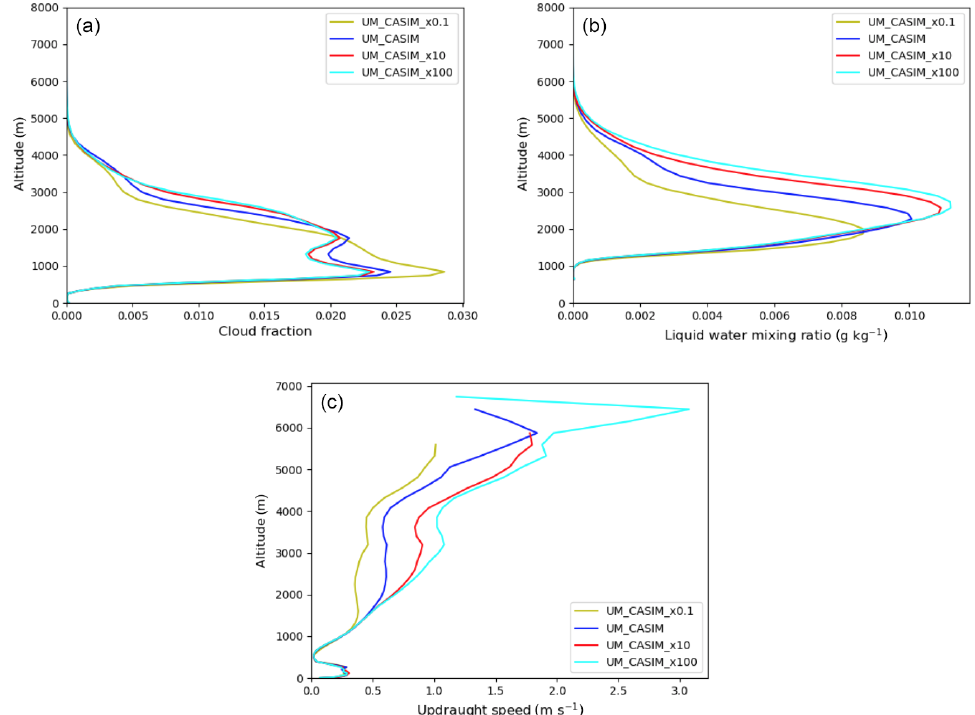
Figure 6. Vertical profiles of domain-averaged liquid water mixing ratio (a) and cloud fraction (b) , calculated for all columns, and updraught speed (c) , calculated for cloudy columns